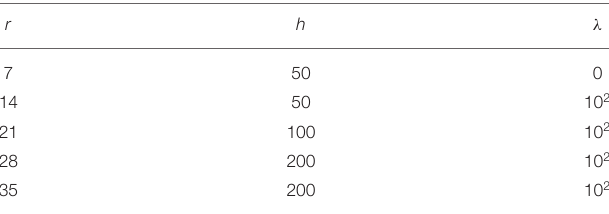
TABLE 1 | A table of the optimal autoencoder parameters for the Lorenz ’96 NN-ROM for different ROM dimensions r